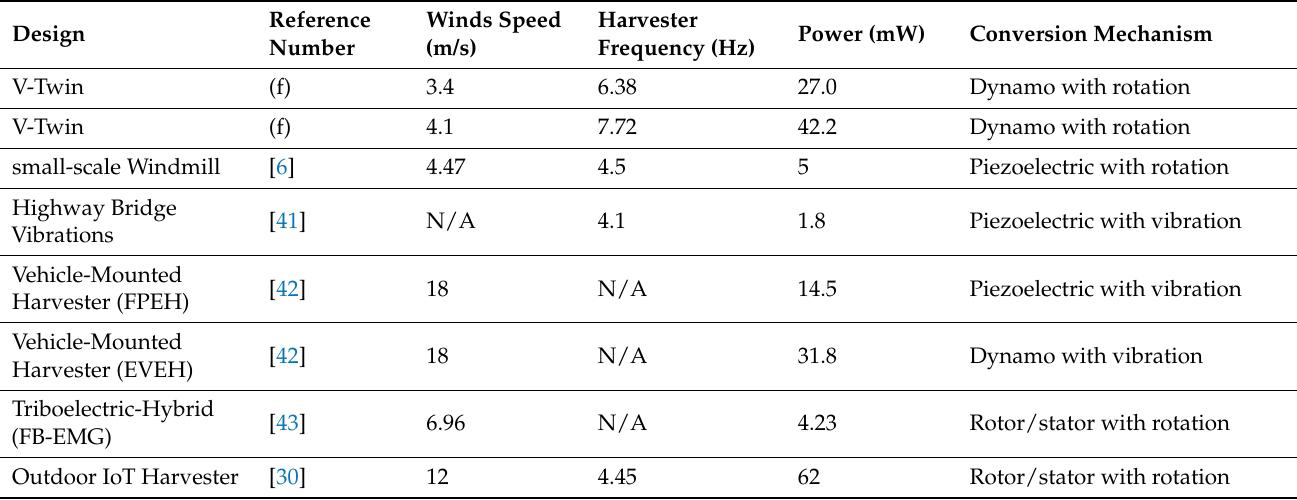
Table 2. Harvester wind speed testing